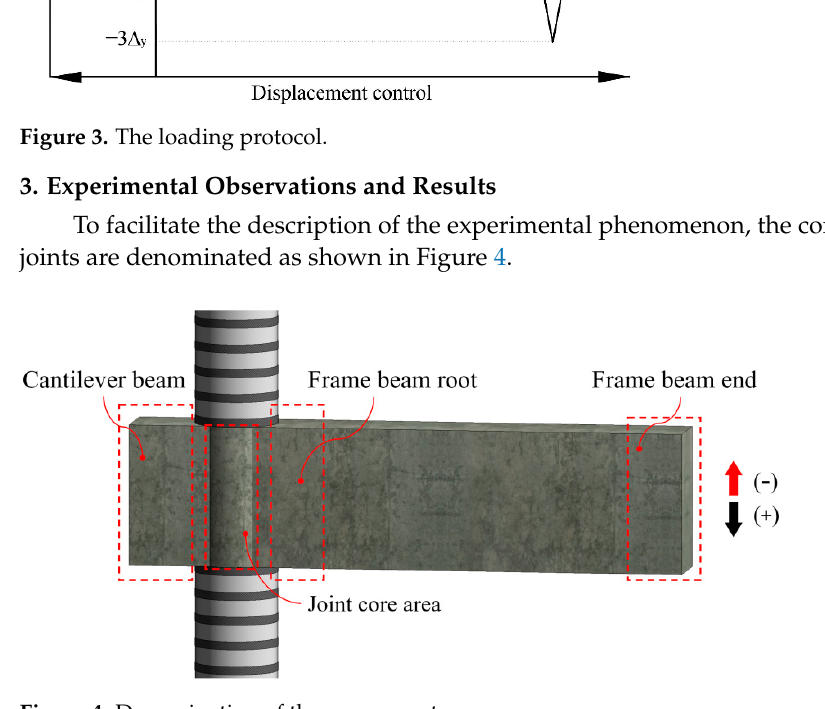
( e ) Figure 5. Typical crack and failure mode. ( a ) Oblique cracks. ( b ) Crossed oblique cracks. ( c ) Cracks extending. ( d ) Concrete spalling. ( e ) Overall failure mode. At the initial loading stage, the specimens have no obvious cracks and exhibit elastic response. With the improvement of the displacement in the frame beam end (hereinafter called displacement), several oblique cracks emerge in the joint core area. Compared with the specimens PJ ‐ 2 and PJ ‐ 4, the above ‐ mentioned oblique cracks of the specimen PJ ‐ 5 is accompanied with a higher displacement, which is mainly because the joint stirrups can provide a slight confinement for the surrounding concrete. At the displacement of 2 Δ y , the oblique cracks are developed into the crossed oblique cracks and extends to the frame beam root and the cantilever beam. Until the peak bearing capacity is reached, the cracks present a stable development without new cracks occur, only the increase in the crack width. In this stage, the improvement in axial compression ratio can further accelerate the cracks development. When loading to the cycle with the displacement of 6 Δ y , severe